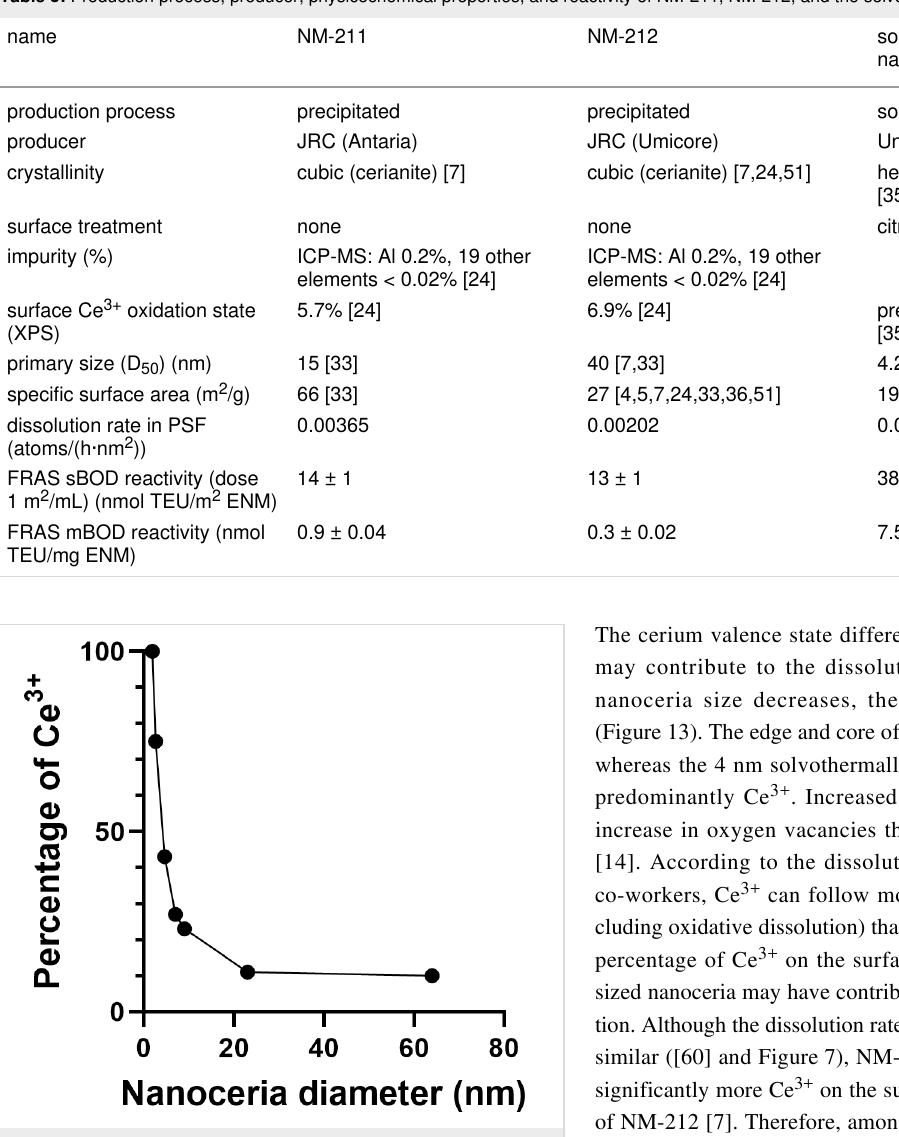
Figure 13: The percentage of surface cerium as Ce 3+ as a function of the nanoceria size. Data taken from [55] and